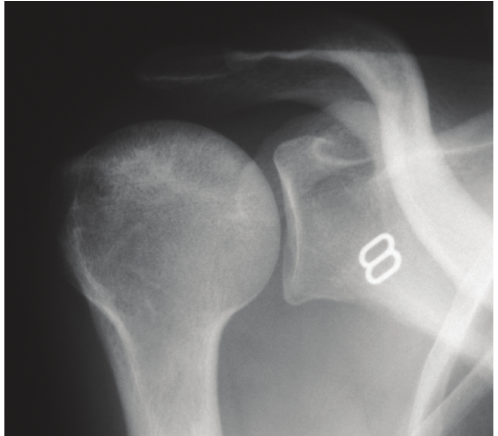
Figure 9: Plain radiograph of the shoulder showing early patchy sclerosis of the right humeral head consistent with early avascular necrosis (snow storm appearance).